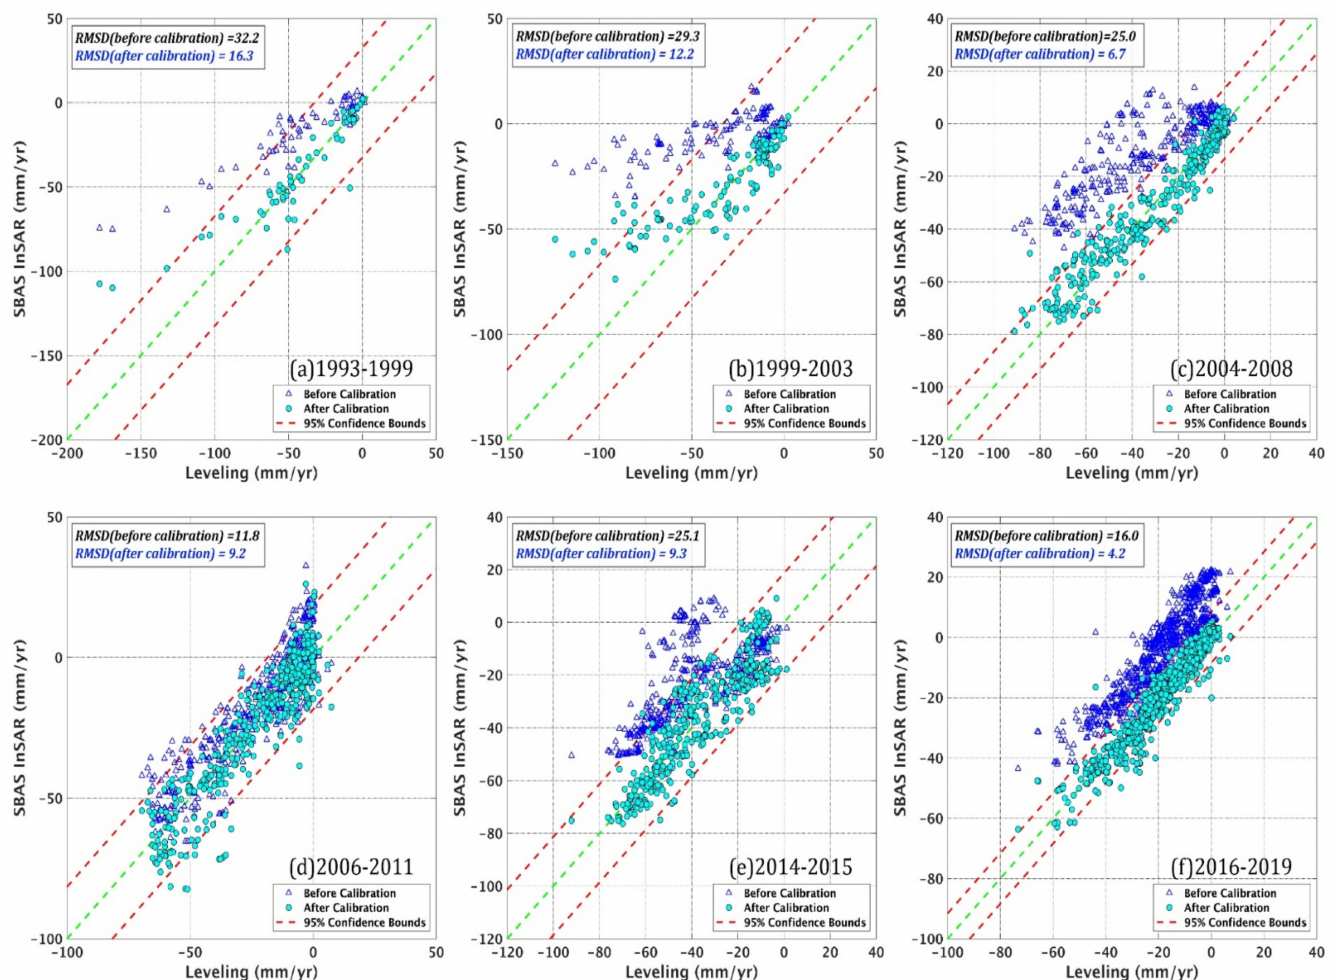
Figure 2. Relationships between the leveling- and InSAR-derived vertical velocities before (blue triangles) and after (cyan circles) the InSAR calibration over the time spans indicated in ( a – f ). The RMS differences values decreased after the